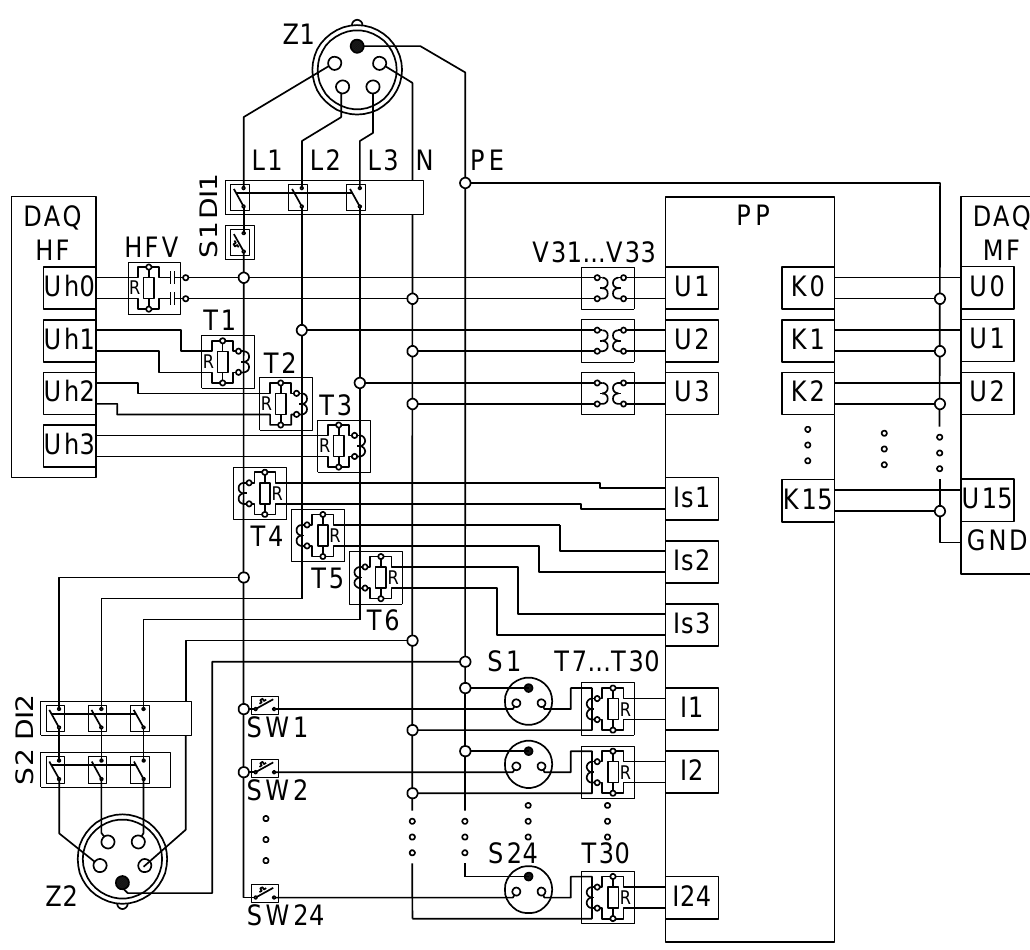
Figure 13. Architecture of the NIALM laboratory.